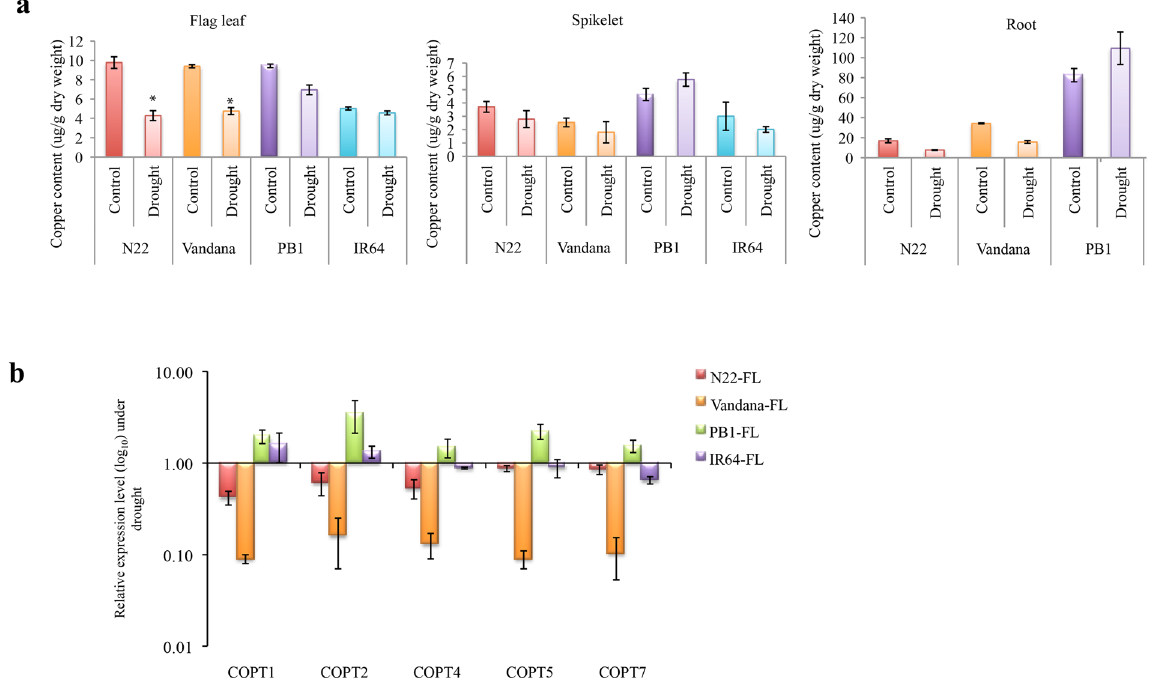
Figure 6. Drought differentially affects the copper homeostasis in drought tolerant and sensitive cultivars. ( a ) Estimation of copper levels in the flag leaf and spikelet collected at heading stage and root collected at milky stage under control and drought stress conditions using atomic adsorption flame spectrophotometer (Soil science, IARI). The graph was plotted with three biological replicates and the bar represents the standard error and the asterisks indicate a significant difference between the indicated samples (two-tailed students t-Test, P ≤ 0.05). ( b ) Expression analysis of genes involved in copper transport was done in the flag leaf of N22, Vandana, IR64 and PB1 at heading stage under drought conditions. At least seven biological replicates and three technical repeats were used for the expression analysis. The error bars represent the standard error. Actin was used as normalization